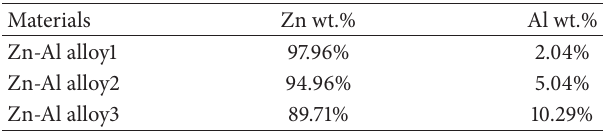
Table 2: Element compositions of 3 zinc aluminum alloys prepared by the vacuum melting